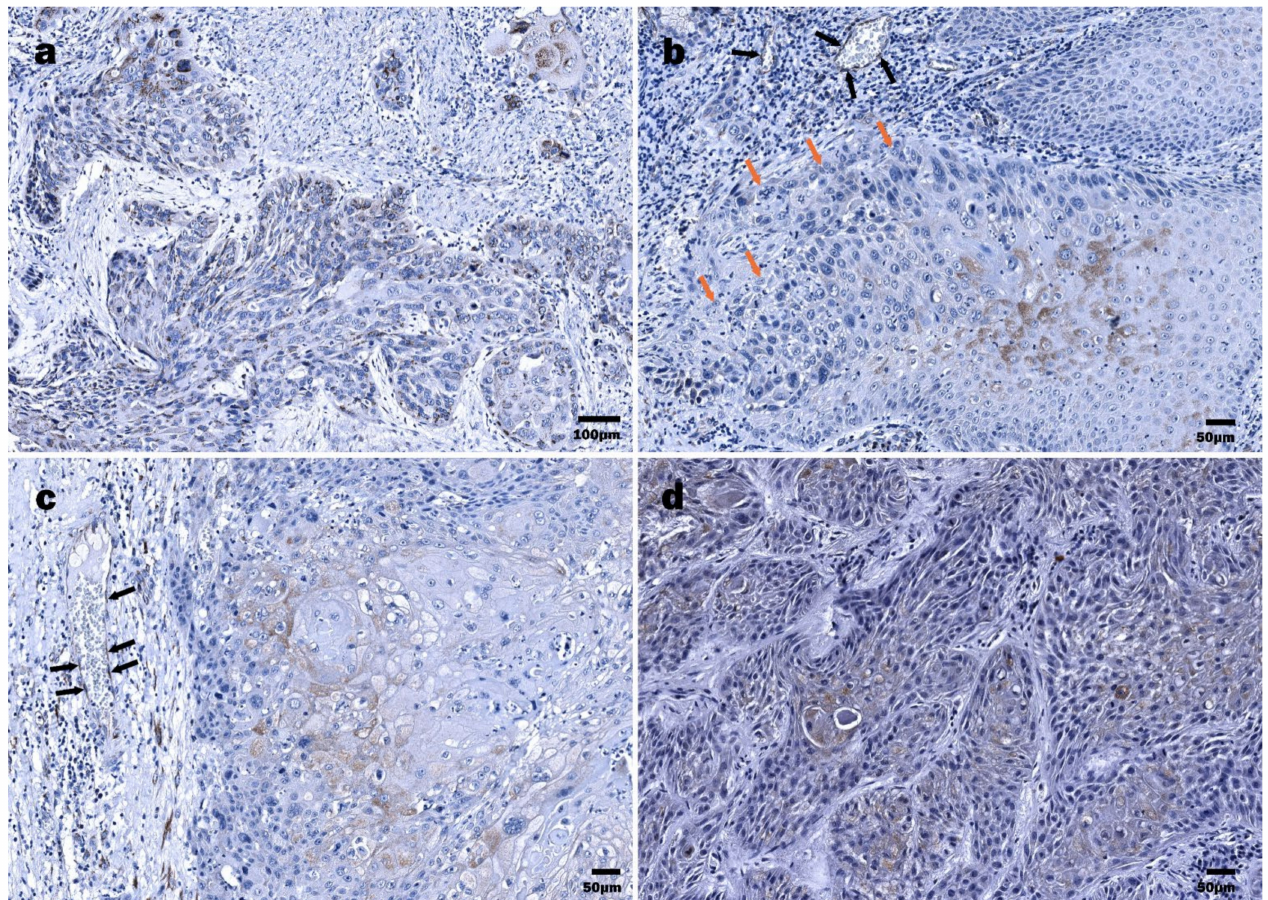
Figure 2. Immunohistochemical detection of HPV16/18 E6 oncoprotein: ( a ) LSCC, tumor cords and nests composed of diffusely distributed E6 protein-positive cells interspersed by the E6 oncoprotein-negative cells; ( b ) LSCC, differentiated suprabasal tumor cells demonstrating abundant HPV16 E6-positive cytoplasm and polymorphous nuclei (orange arrows), E6-positive endotheliocytes (black arrows) within a tumor stroma; ( c ) LSCC, HPV16/18 E6 positivity in suprabasal, more differentiated tumor cells; E6-positive endothelial cells (black arrows); ( d ) HPSCC, densely packed tumor cords demonstrating HPV16 E6 oncoprotein positivity, almost exclusively in more differentiated